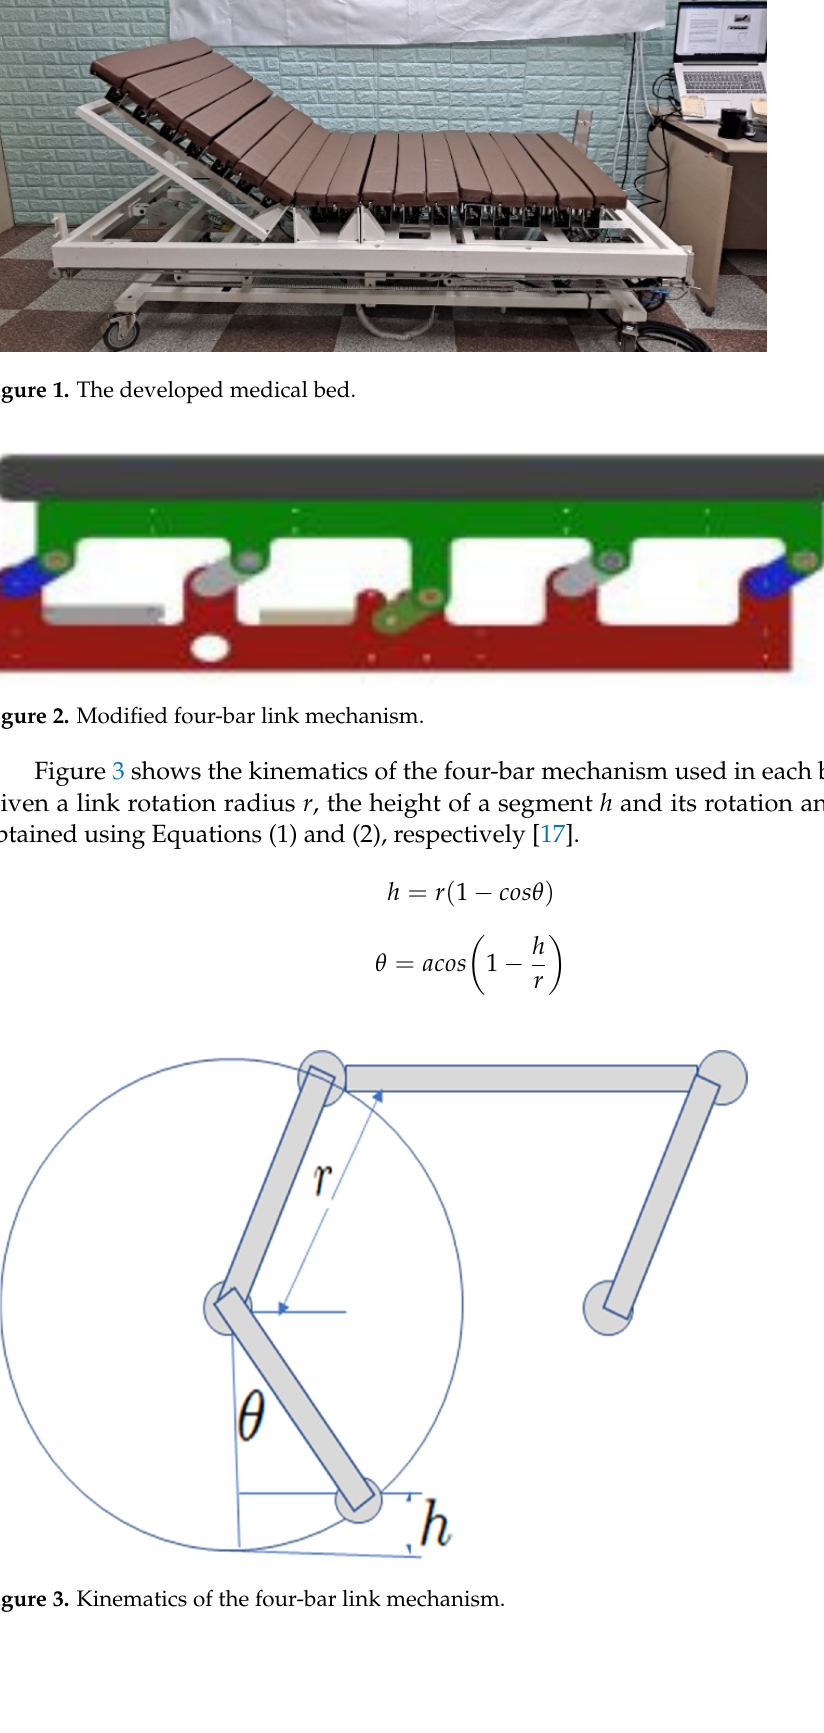
Figure 3. Kinematics of the four-bar link mechanism.